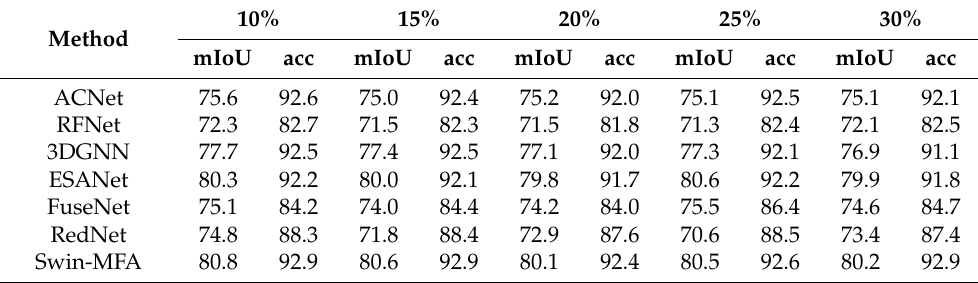
Table 4. The results of experiment in datasets of different light